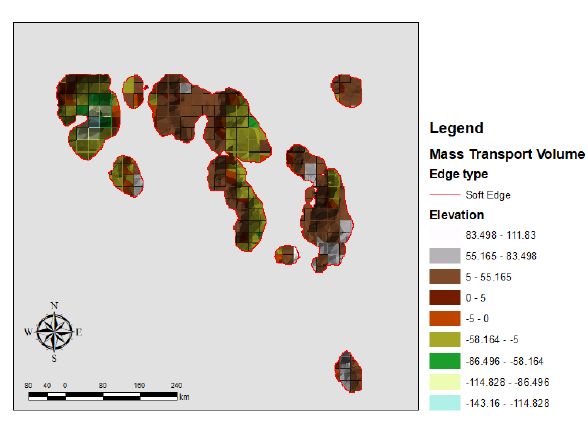
Figure 15 . Mass transport volume.